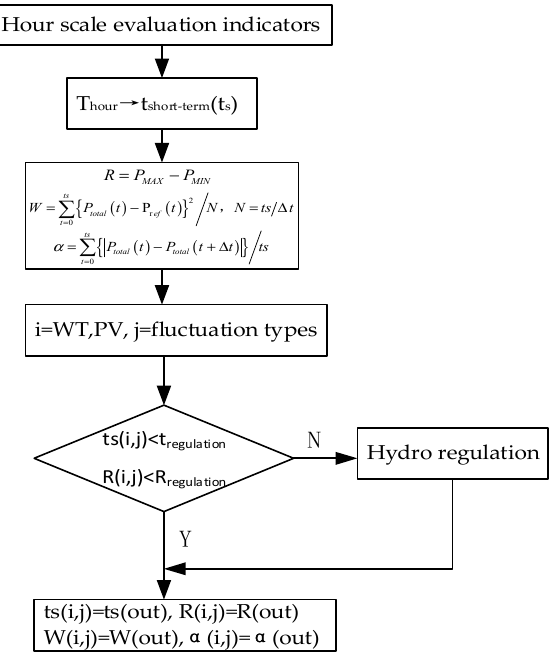
Figure 2. Flow chart of the simulation method.